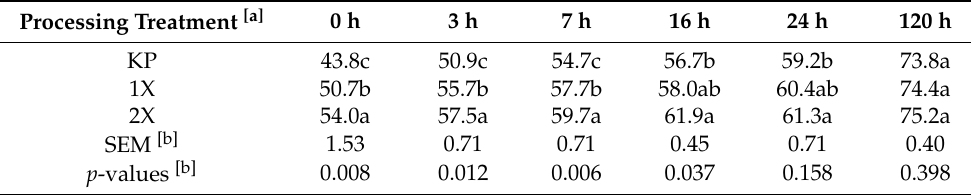
Figure 5. In situ dry matter disappearance (DMD) versus time (t) for whole-plant corn silage. Processing took place prior to ensiling. Processing level index (PLI) for KP, 1X and 2X treatments averaged 36%, 54% and 67%, respectively. Error bars represent standard error and n = 5. Table 8. In situ dry matter disappearance of whole-plant corn silage at each of the six time points (n = 5). Treatments were processed prior to